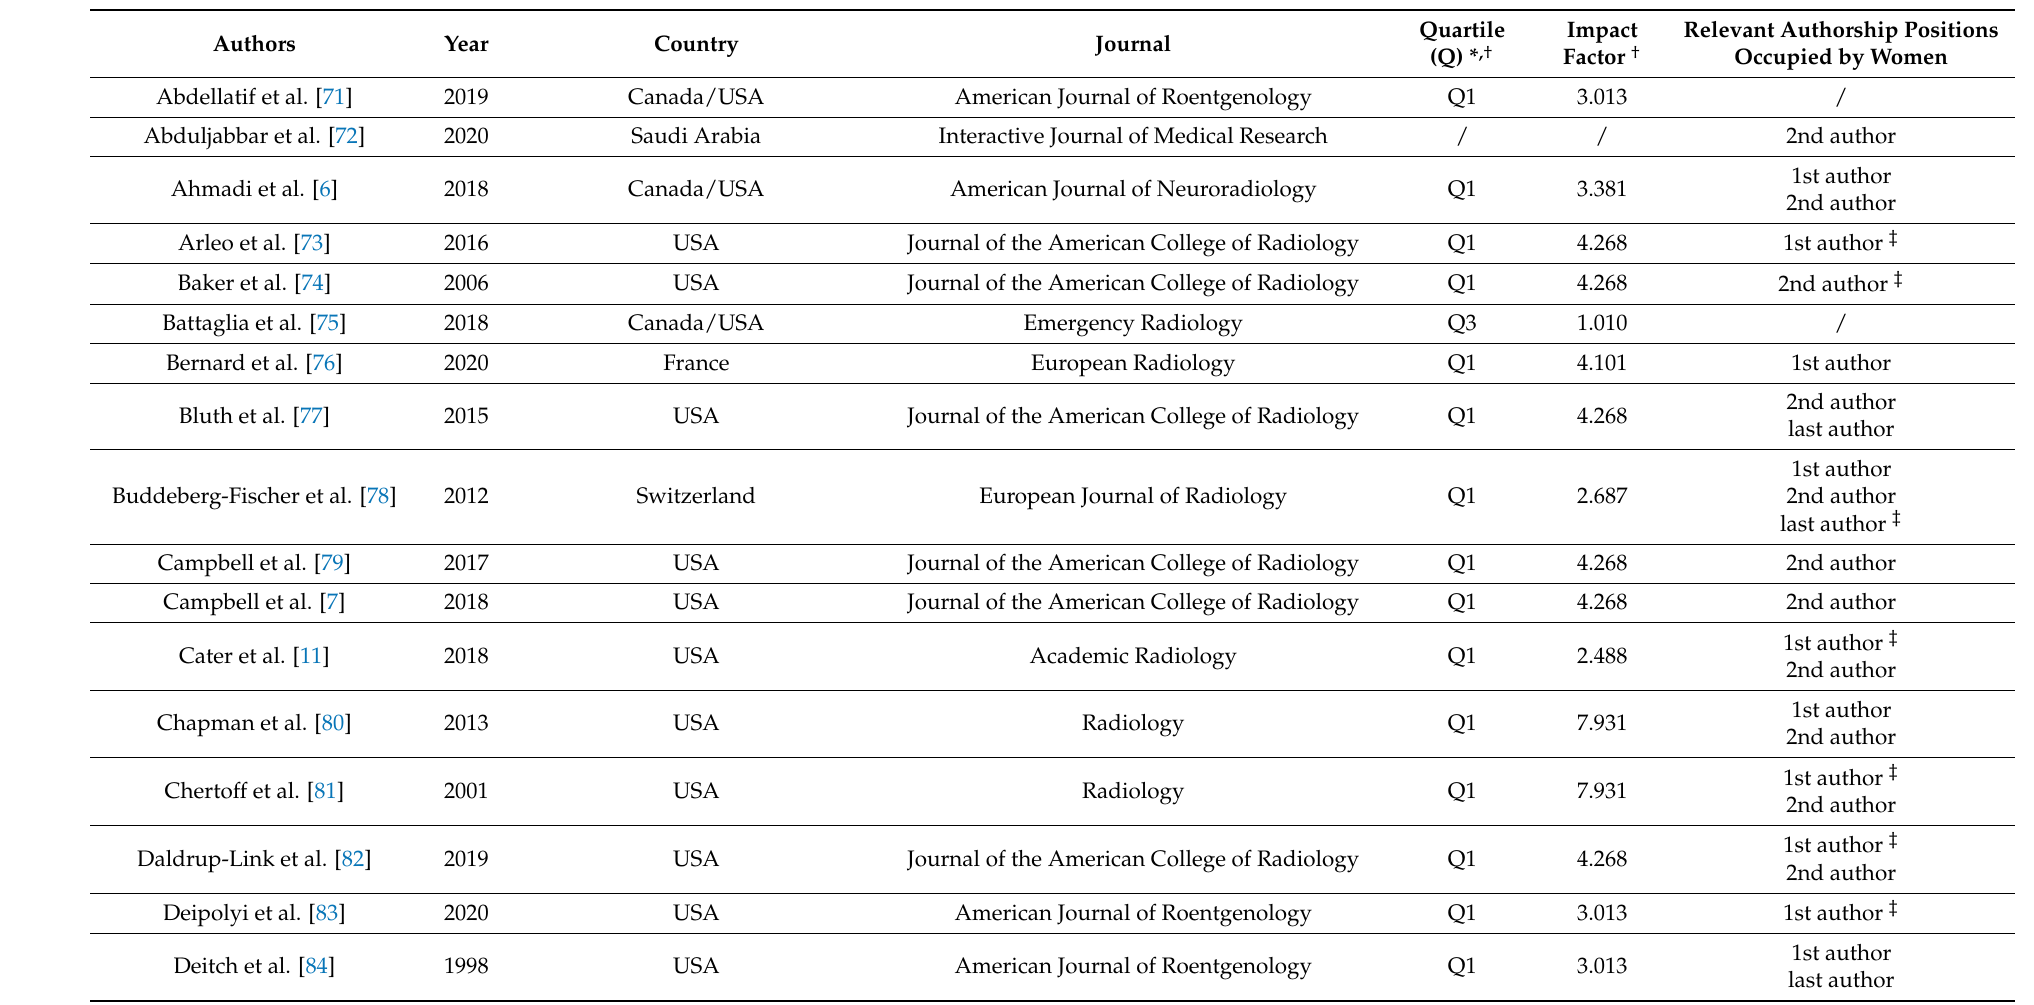
Table 1. Characteristics of the 61 included